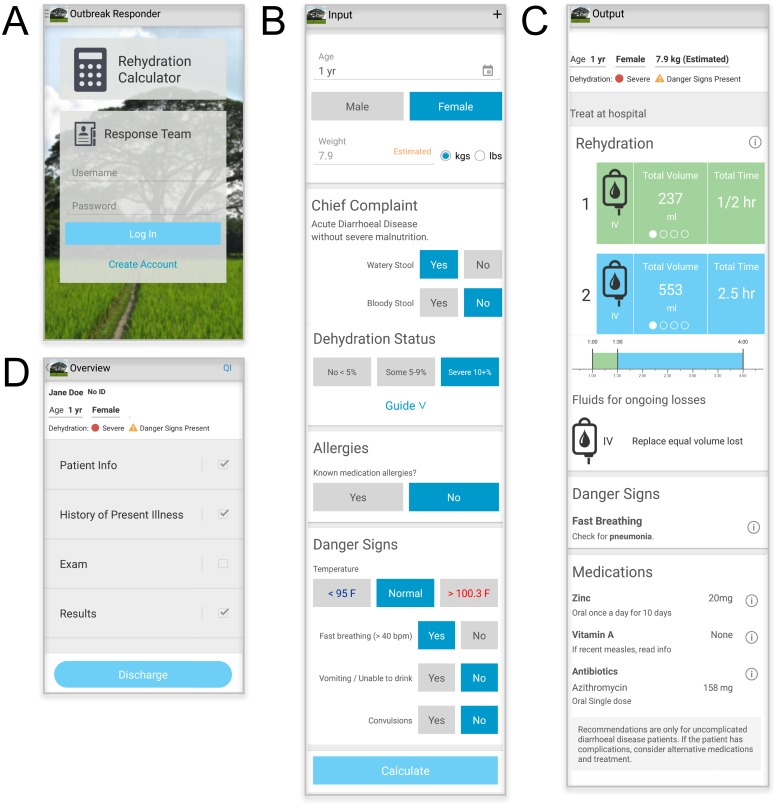
Rehydration calculator.(A) Home page with the Rehydration Calculator for decision-support (upper) and the data collection platform (lower). (B) Data input page. (C) WHO derived recommendations for medication and fluid administration; units can be changed by side-swiping. “i” represents a link to educational summaries and primary publications. (D) Outbreak Responder data collection and aggregation platform for the research team (aka ‘Response Team’). ‘QI’ is a portal for customized quality improvement questions intended to be used by researchers only.